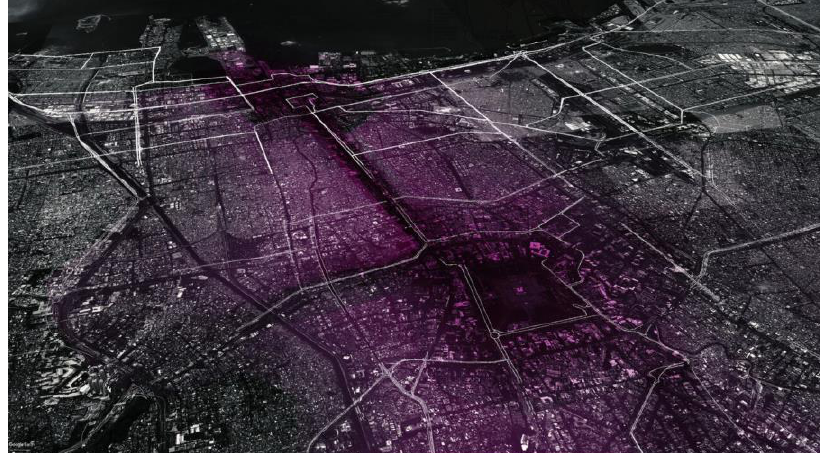
Figure 19. Study map manifesting the city’s urban planning’s core mediating the two city centres upon which the city relies greatly (Developed by